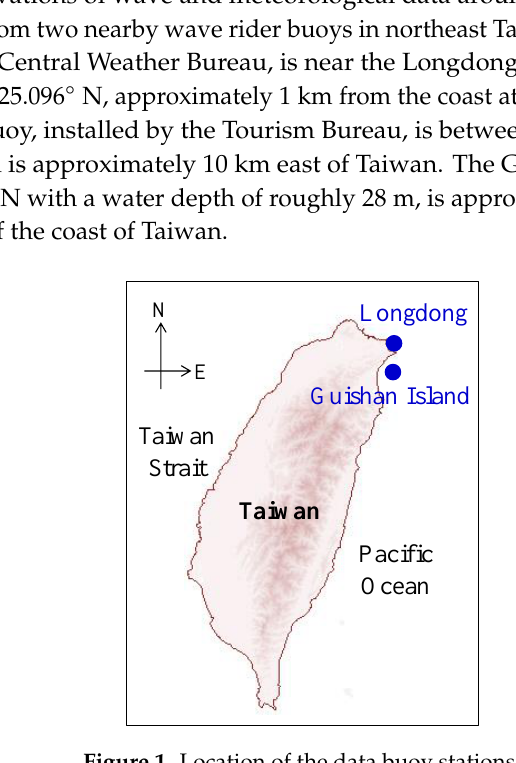
Figure 1. Location of the data buoy stations.